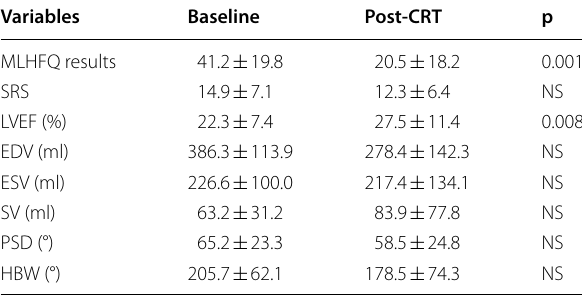
Variables are expressed as mean